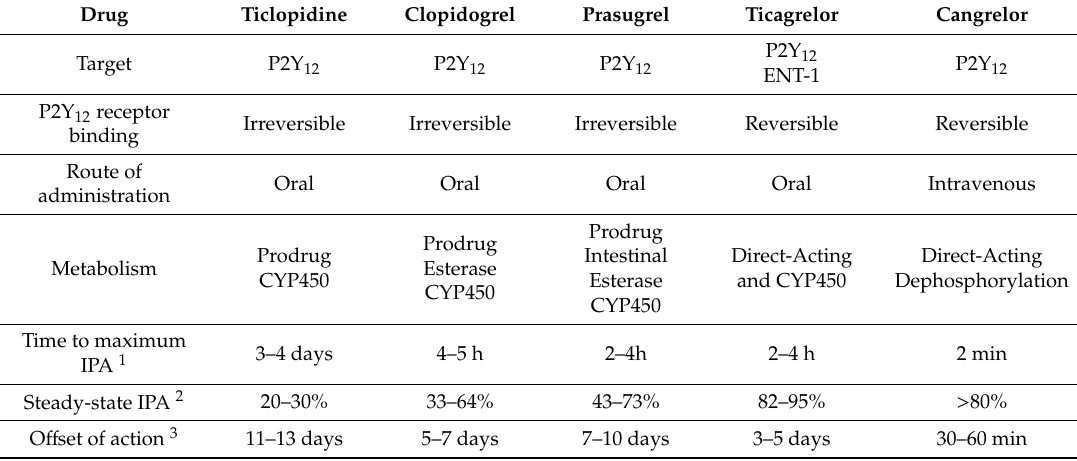
Table 1. Pharmacological properties of P2Y 12 receptor